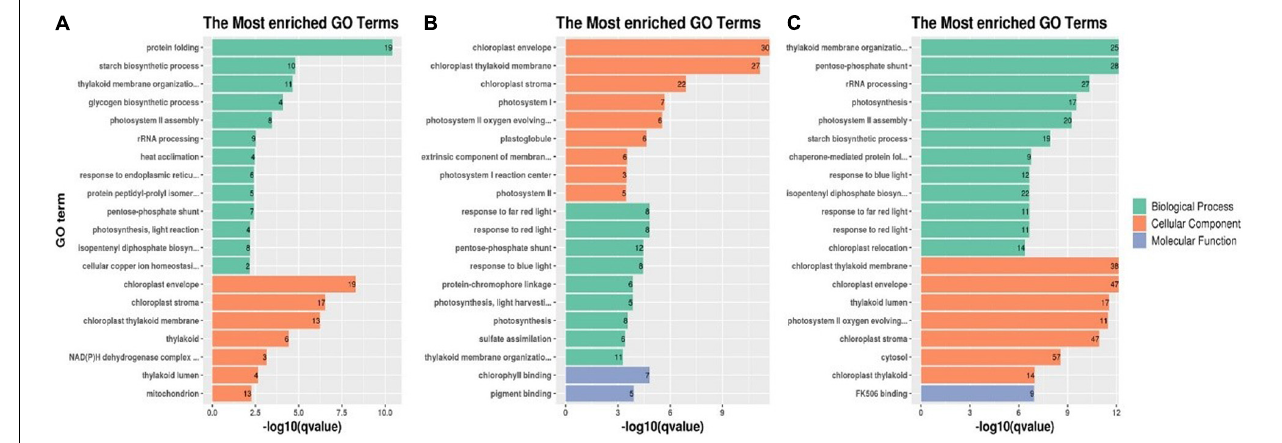
FIGURE 7 | Twenty most enriched GO terms of DEPs in the T0d vs. T10d (A) , T10d vs. T20d (B) , and T0d vs. T20d groups (C) . For details of the GO enrichment analysis of DEPs, see Supplementary Spreadsheet 4 and Supplementary Figures 2–4 .